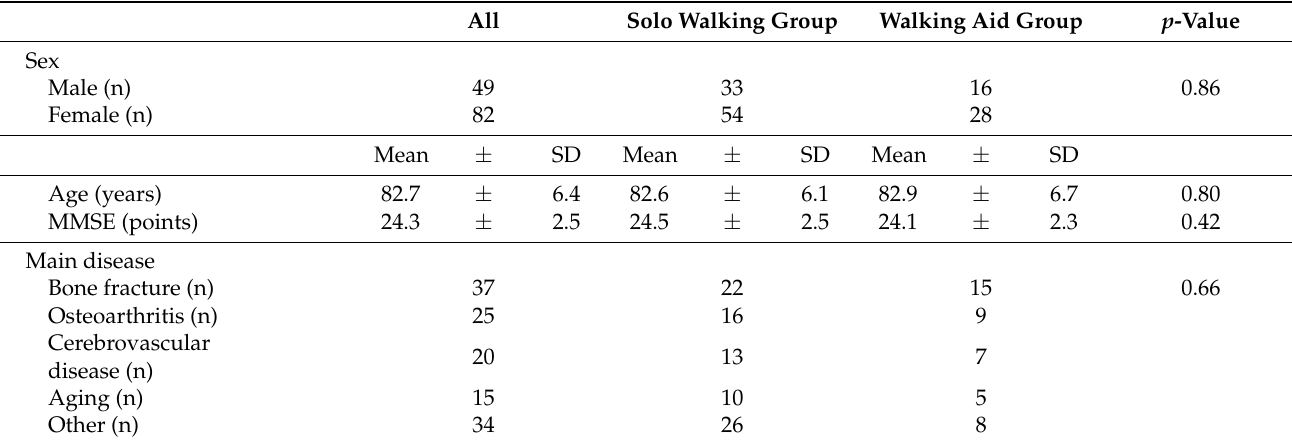
Table 1. Comparison of basic attributes between the two groups. All Solo Walking Group Walking Aid Group p -Value